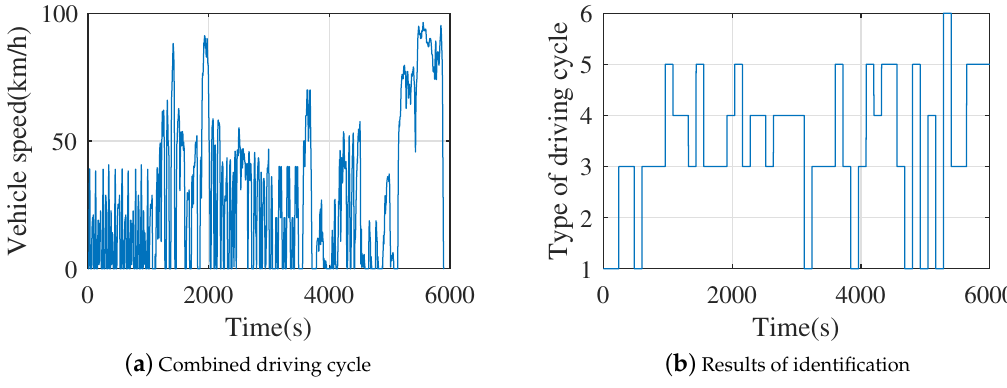
Figure 13. Combined driving cycle and results of identifications.